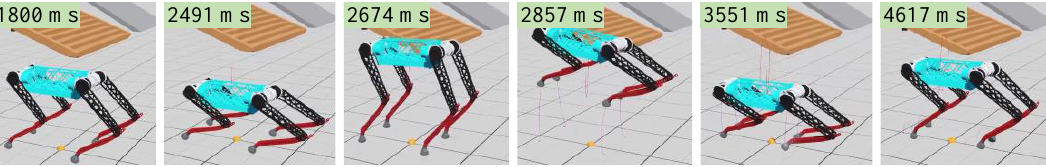
Figure 13. Snapshots of BQR3 ’s jumping motion.